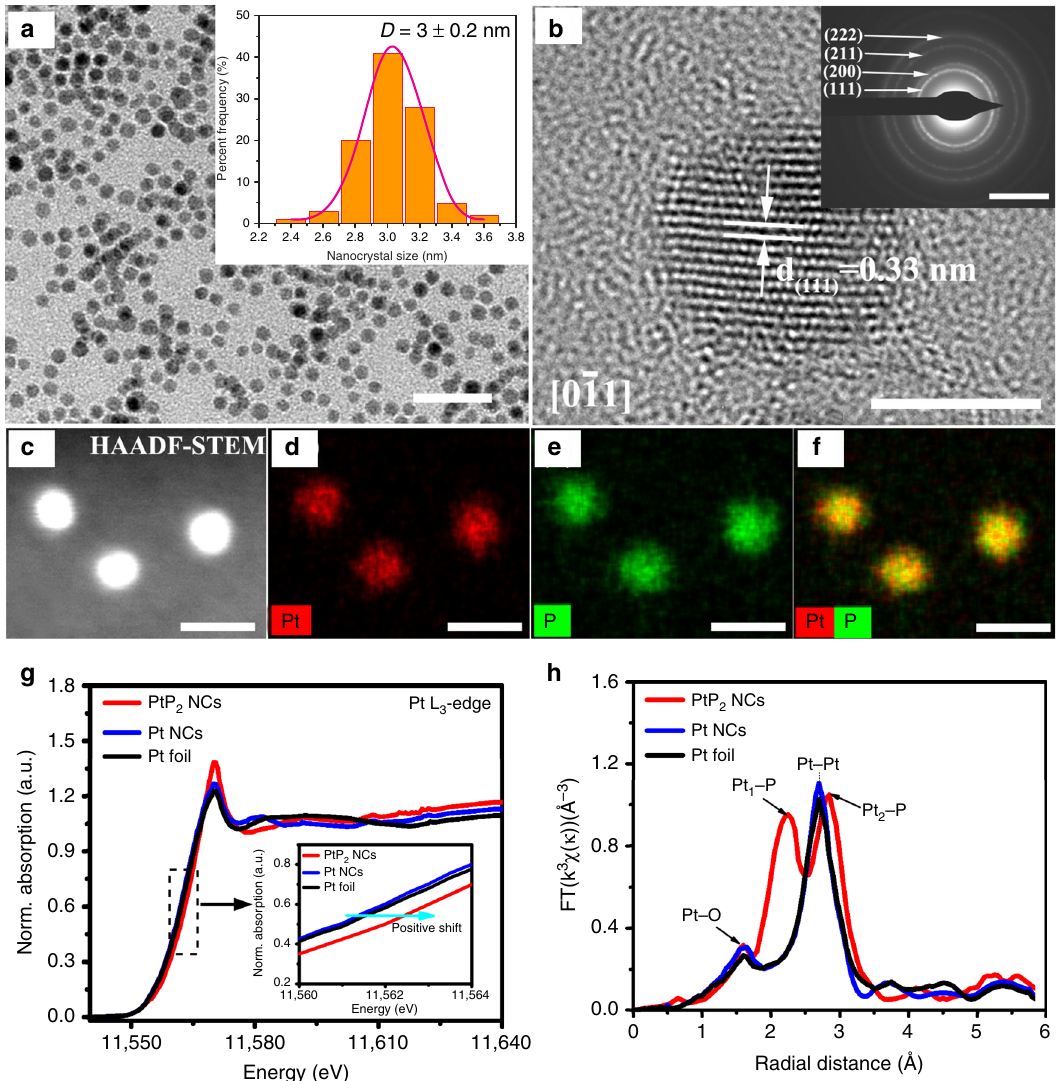
Fig. 1 Materials characterization of PtP 2 NCs. a TEM image; scale bar, 20 nm. b HRTEM image; scale bar, 2 nm, inset is the selected-area electron diffraction (SAED) image; scale bar, 5 1/nm. c HAADF-STEM, and d – f elemental mapping images of PtP 2 NCs; scale bar, 5 nm. g Pt L 3 -edge X-ray absorption near-edge structure (XANES) and h extended X-ray absorption fi ne structure (EXAFS) spectra of PtP 2 NCs, Pt NCs, and Pt